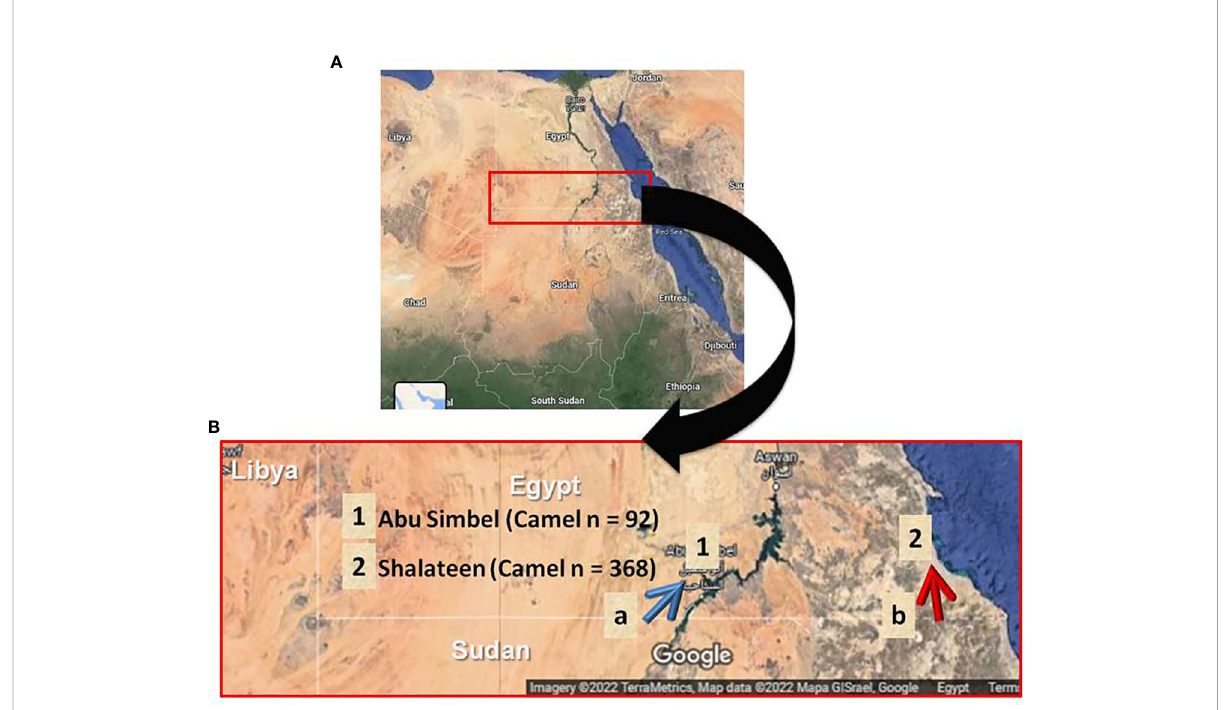
FIGURE 1 Geographical location of sample collection. (A) Map of Egypt illustrating the collection sites for camel samples in Southern Egypt. (B) Landscape enlarged area of testing samples. Blue arrow indicates the journey route of camel herds after crossing the Sudanese-Egyptian border at Argeen checking point (a) until reaching Abu Simbel quarantine (1). Red arrow shows the journey path of camel herds after crossing the Sudanese- Egyptian border at Ras Hadarba checking point (b) until reach Shalateen quarantine